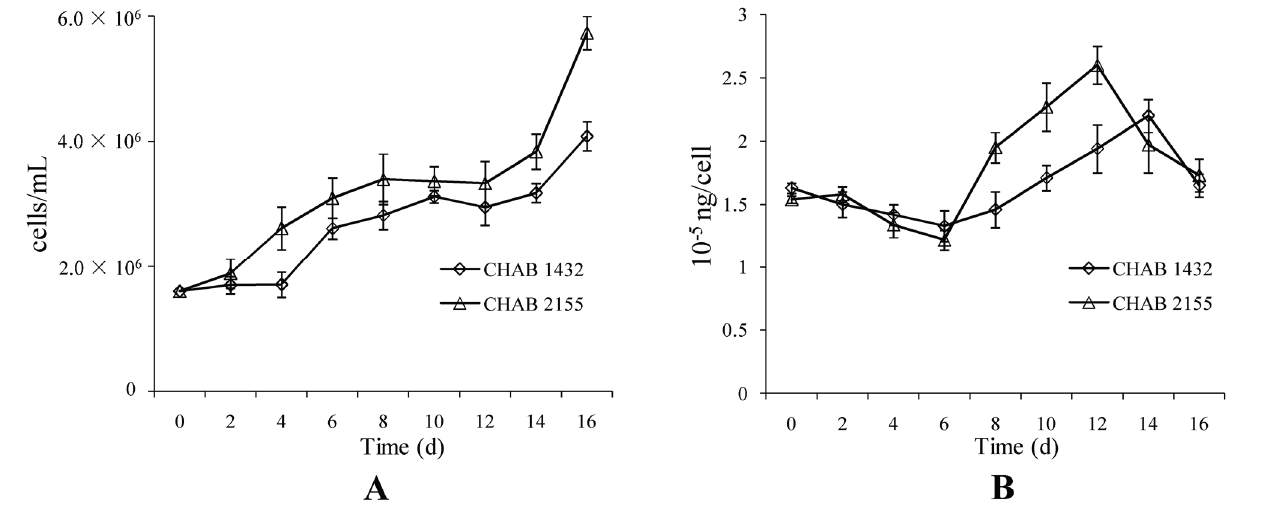
Figure 1. Cell growth ( A ) and geosmin productions ( B ) of A. ucrainica CHAB 1432 and 2155 in the test cycle.